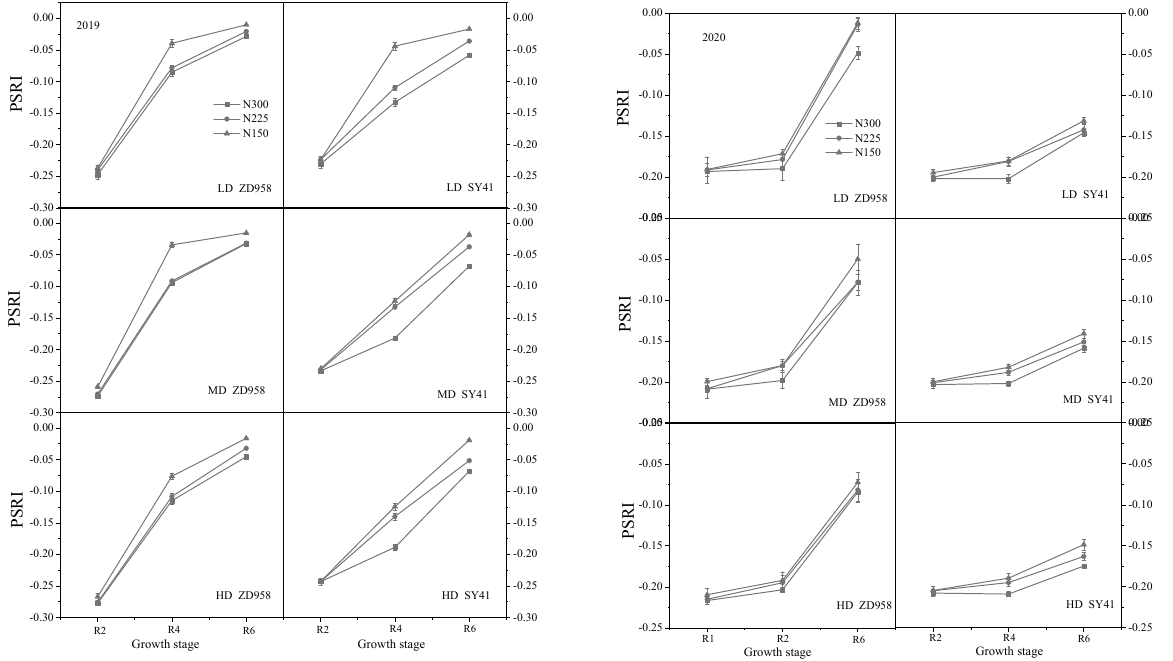
Figure 6. Effects of decreasing N rates under different planting densities on PSRI in 2019 and 2020. Table 3. Eigenvalue and contribution of each comprehensive index.